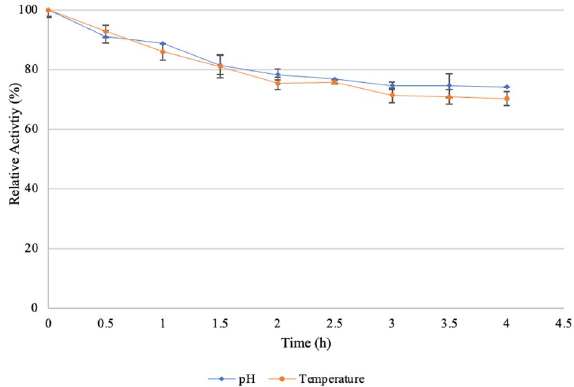
Figure 9. pH and temperature stability of purified xylanases (50% ammonium sulphate fraction) produced by the Trichoderma harzianum isolate. Data points represent the means ± SD (n = 4).